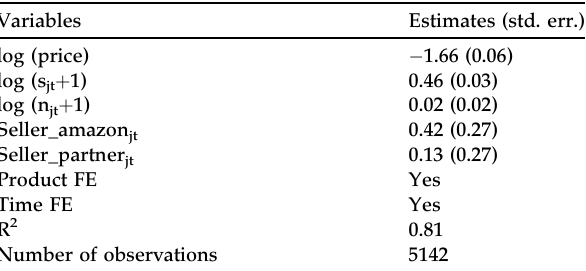
Table 1. Regression estimation result. Variables Estimates (std. err.) log (price) (cid:1) 1.66